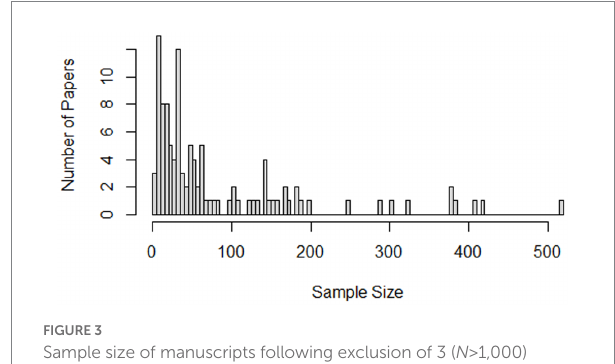
FIGURE 3 Sample size of manuscripts following exclusion of 3 ( N > 1,000)